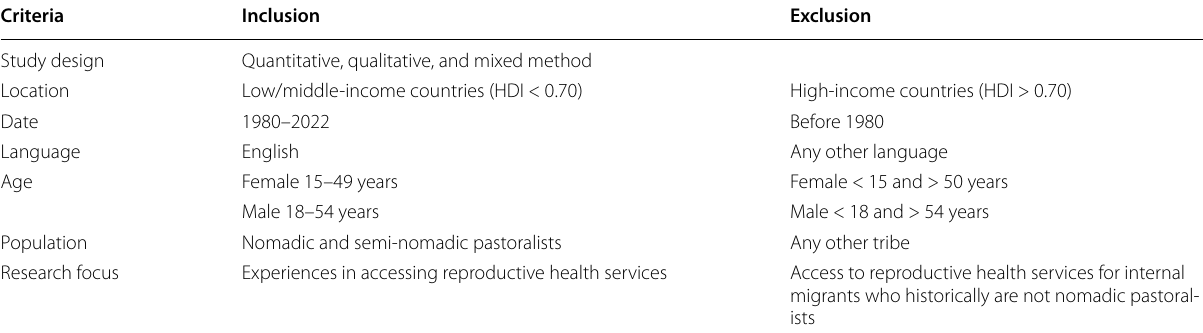
Table 1 Inclusion/exclusion criteria